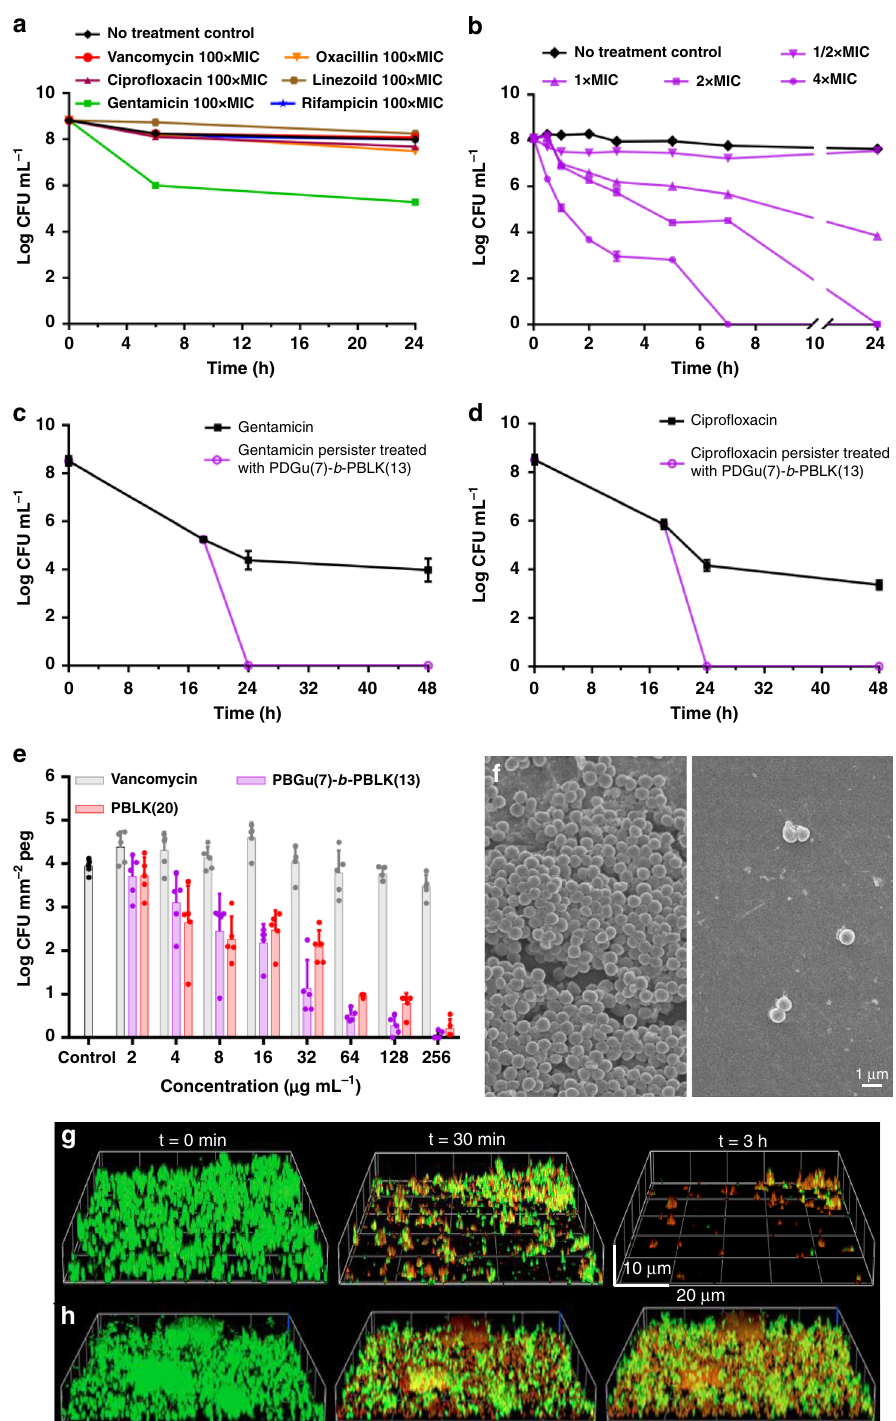
Fig. 4 PDGu(7)- b -PBLK(13) is bactericidal toward MRSA USA300 persisters and bio fi lms in vitro. a Kill-kinetics of various antibiotics at 100× MIC; and b PDGu(7)- b -PBLK(13) against non-replicating MRSA USA300. c , d Kill-kinetics of PDGu(7)- b -PBLK(13) at 4× MIC against persisters generated by 10× MIC gentamicin ( c ) and cipro fl oxacin ( d ) treatment. e Activity of PDGu(7)- b -PBLK(13) and PBLK(20) on established MRSA bio fi lms using the MBEC ™ Assay. Data are presented as mean ± standard deviation. f FESEM image of MBEC ™ microtiter plate pegs: (left) control peg without treatment and (right) peg treated with PDGu(7)- b -PBLK(13) . g , h Confocal microscopy images of PDGu(7)- b -PBLK(13) ( g ) and PBLK(20) ( h ) treated MRSA bio fi lm at t = 0 min, 30 min, and 3 h. Bio fi lms were stained with Live/Dead BacLight ™